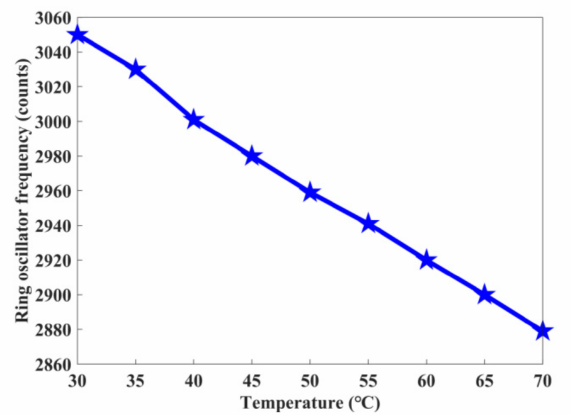
Figure 12. Dependence of ring oscillator frequencies on temperature.